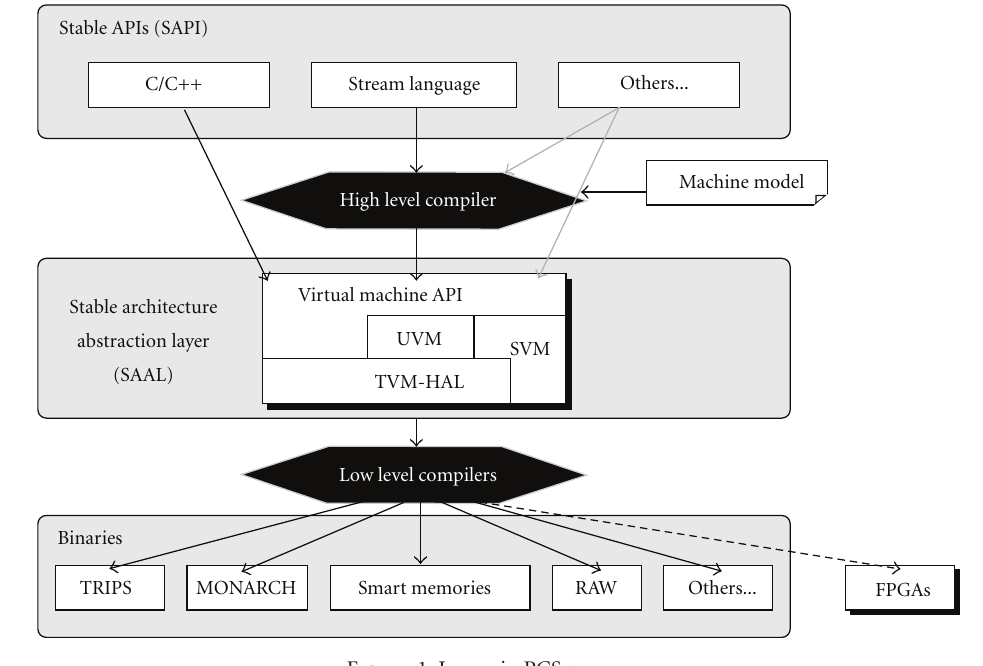
Figure 1: Layers in PCS program.